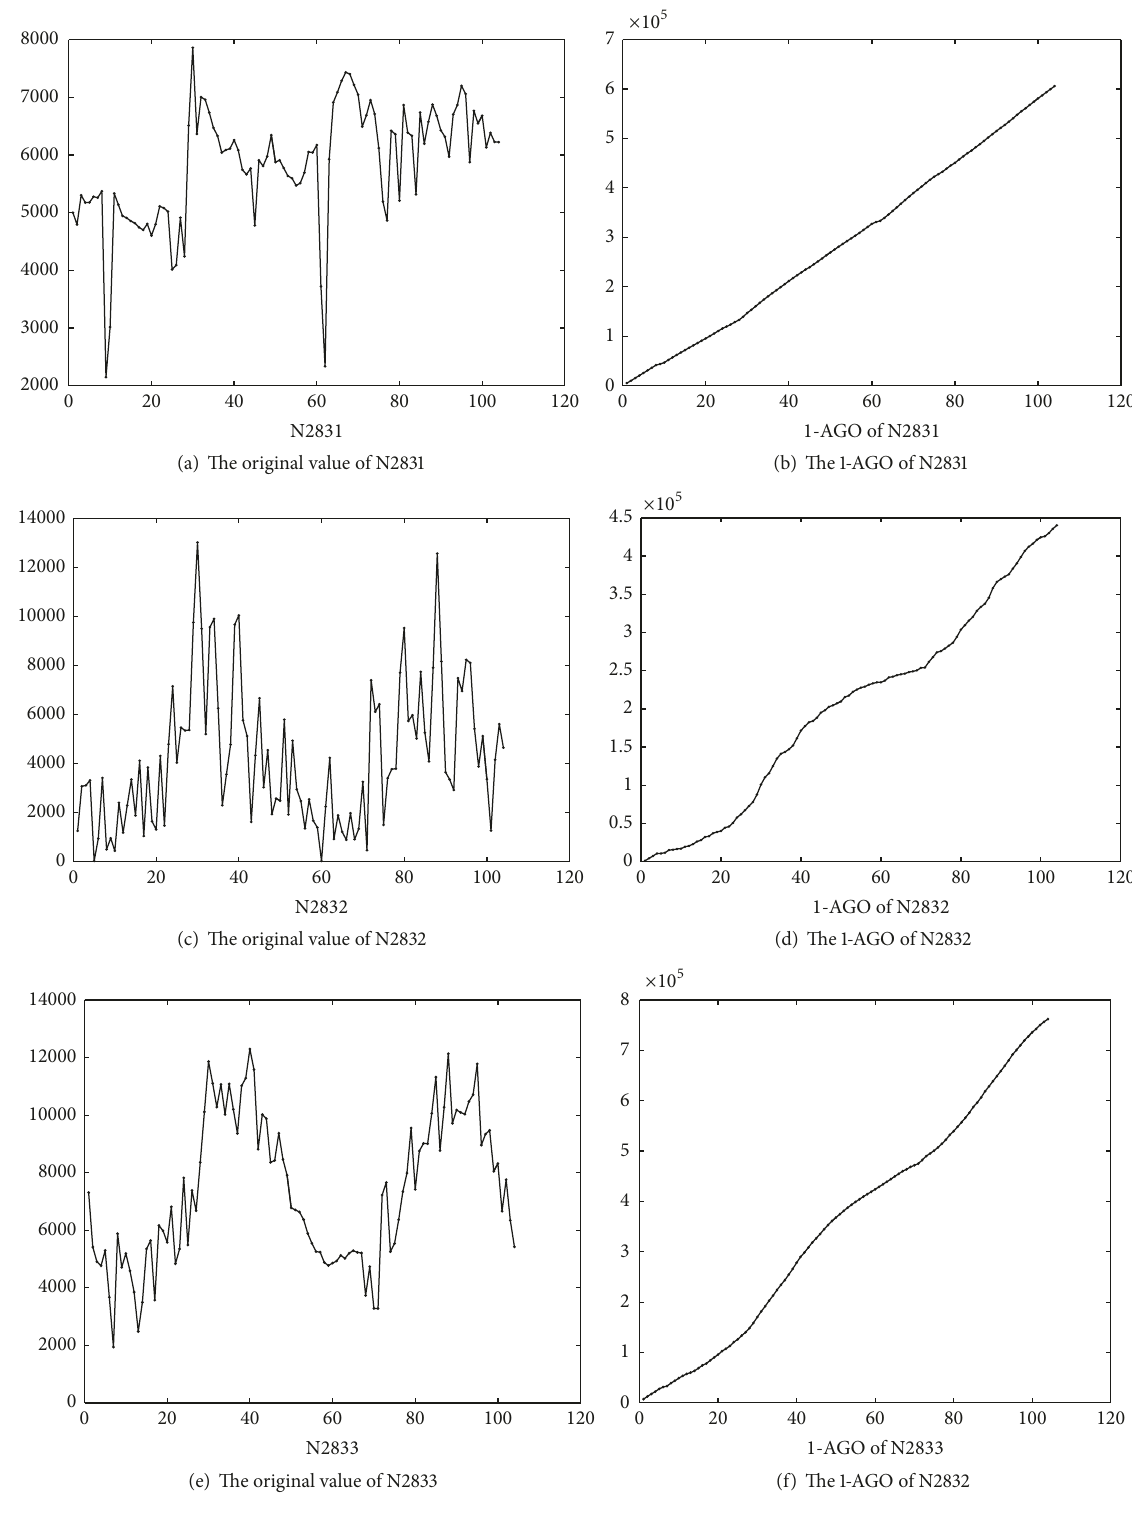
Figure 1: The original value and one order accumulation value of three groups